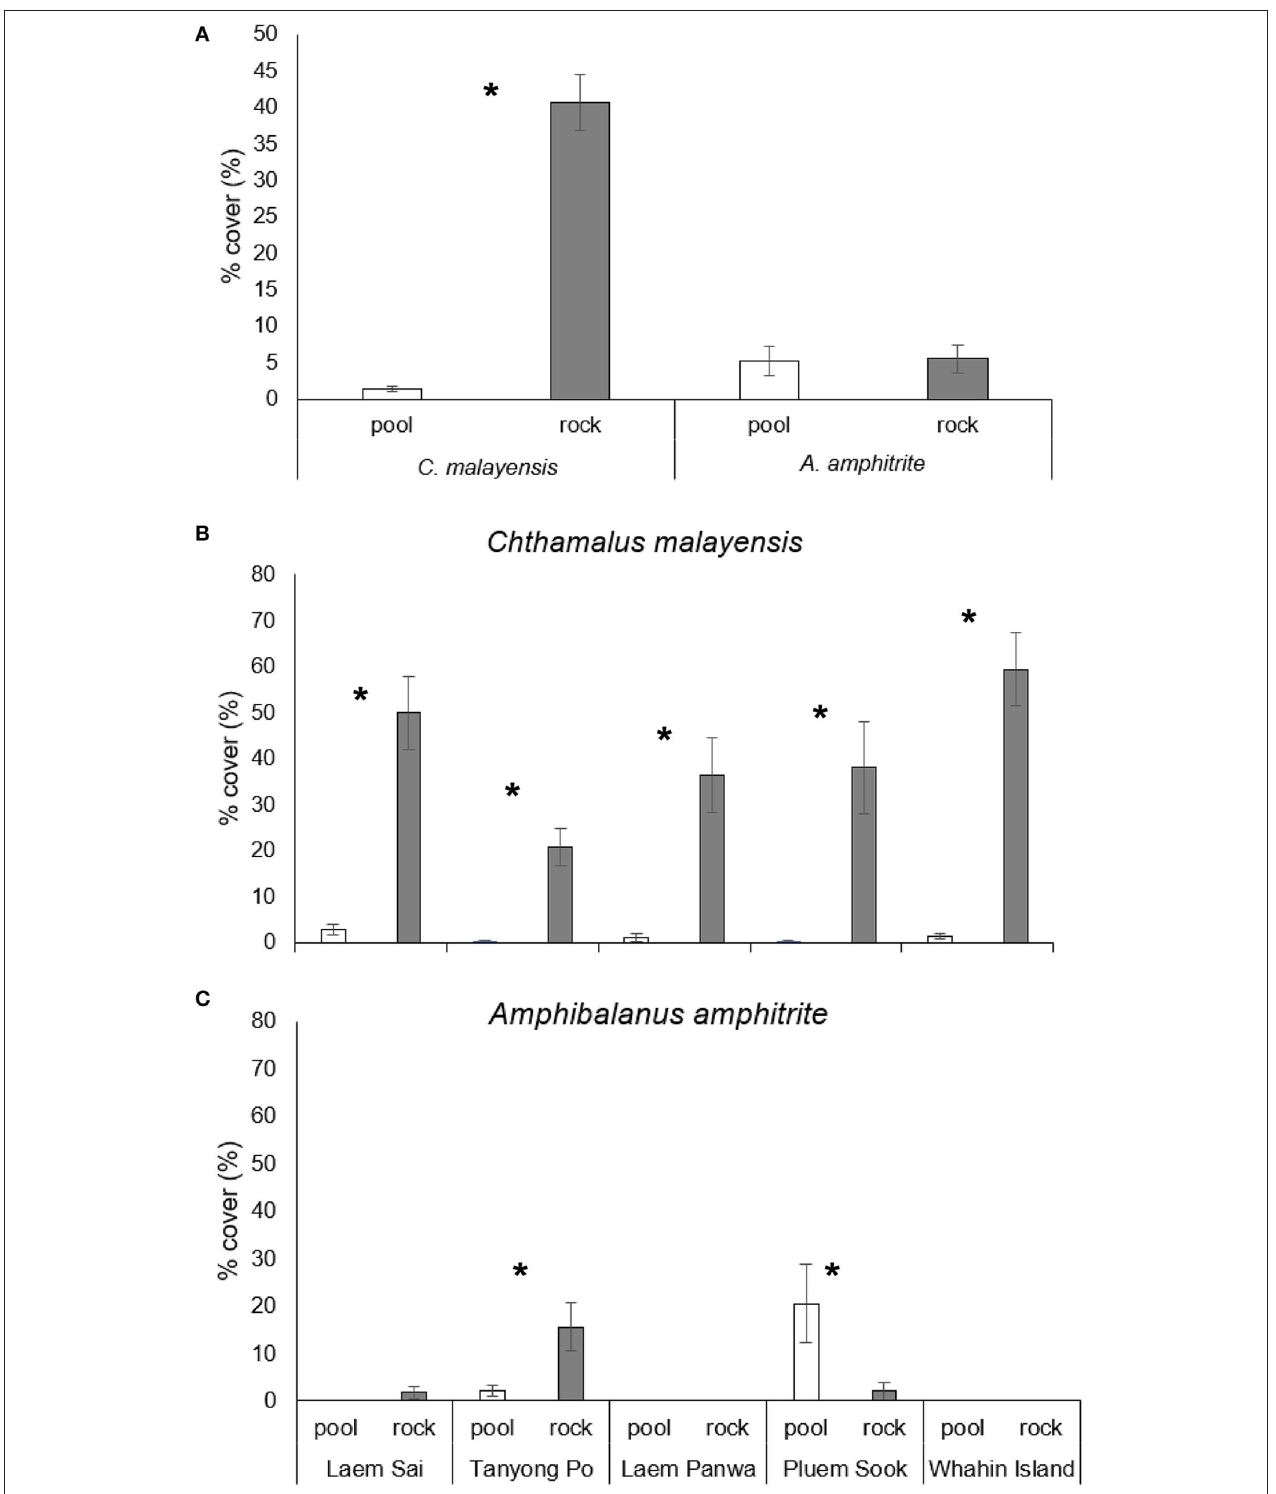
FIGURE 4 | Percentage cover of barnacles in rock pools and on open rock surfaces adjacent to pool. (A) Percentage cover of barnacles (mean ± SE) pooled from all shores. (B,C) Percentage cover on five shores of C. malayensis and A. amphitrite, respectively. Icon: * = significant differences between habitats suggested by pairwise